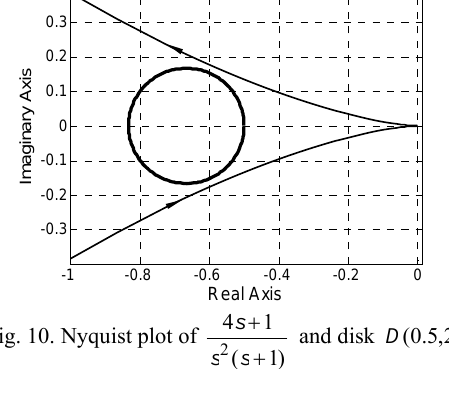
Fig. 10. Nyquist plot